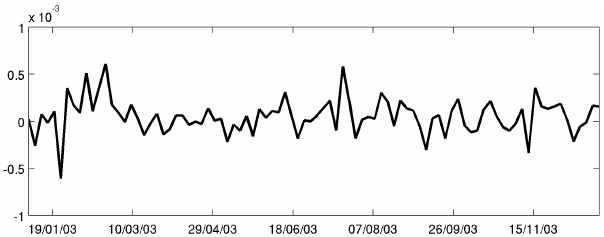
Figure 16. Time series of the cycle-average temperature compo- nents of η averaged over the entire water column and over the northern CCS region indicated in Fig. 4 during 2003 for experiment BHM. The units are ◦ C per time